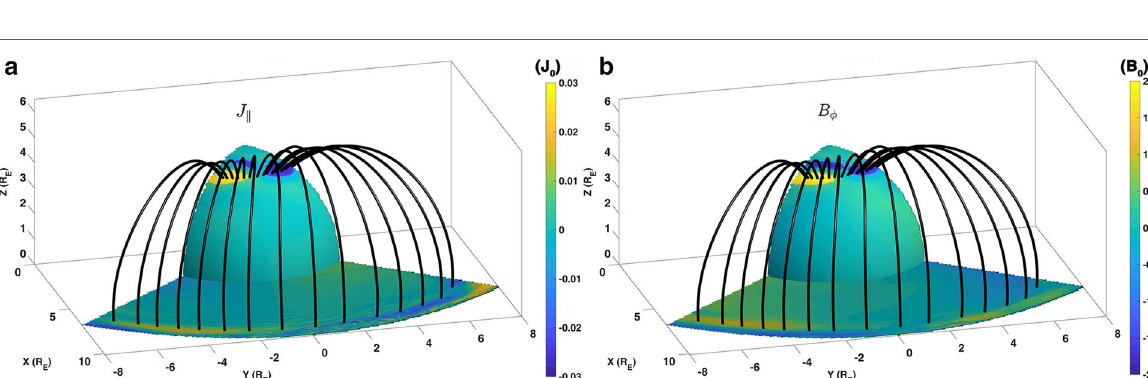
and b B φ in the equatorial plane and northern hemisphere at r ||